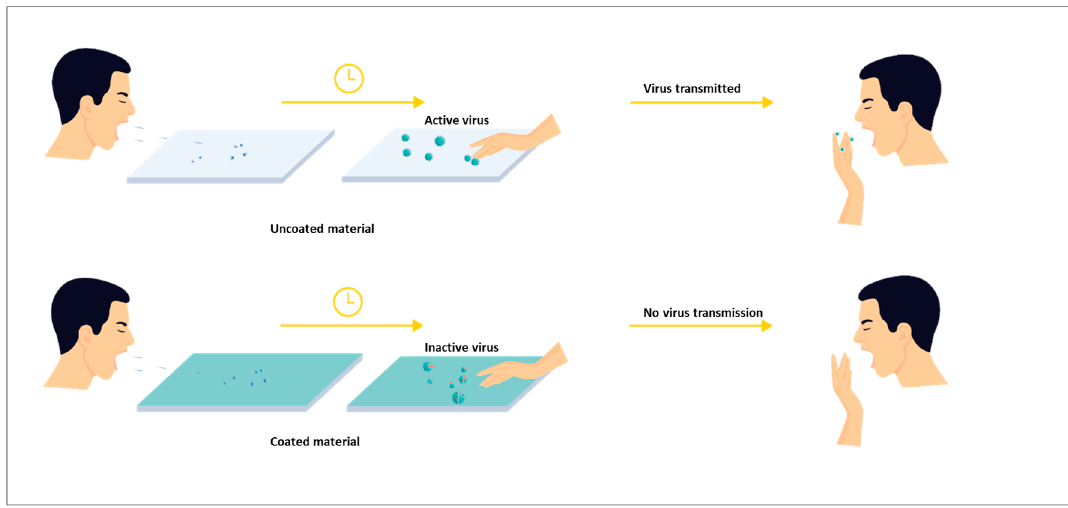
Figure 13. Schematic representation of the antiviral concept through surface coating.